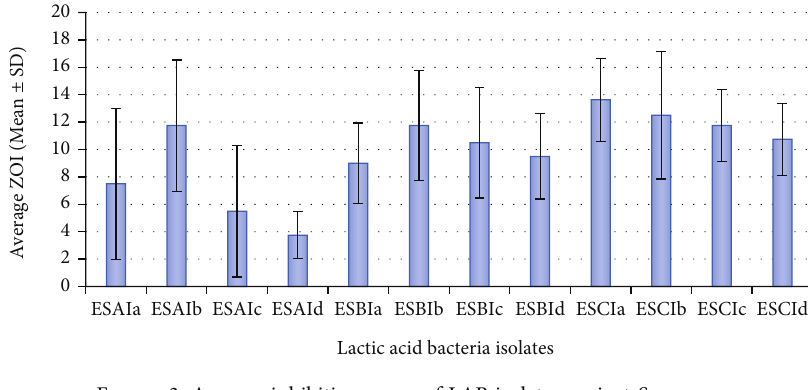
Figure 3: Average inhibition zones of LAB isolates against S.